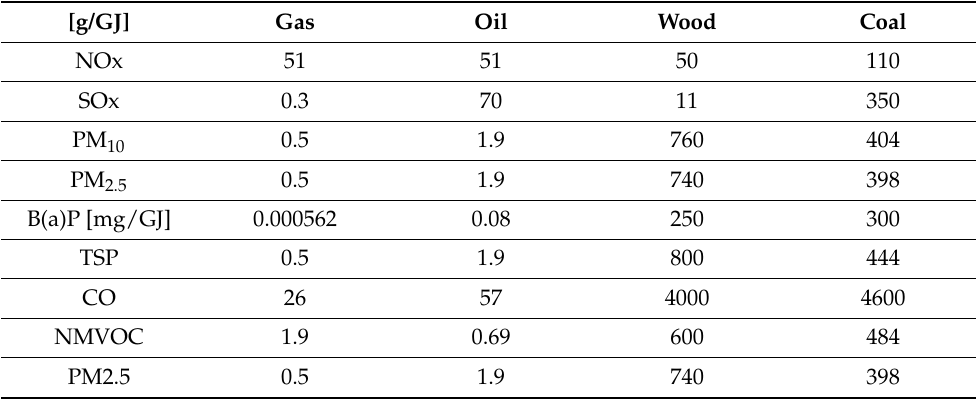
Figure 1. Flowchart of residential heating emission calculation. Table 2. Emission factors used for residential emission estimation.